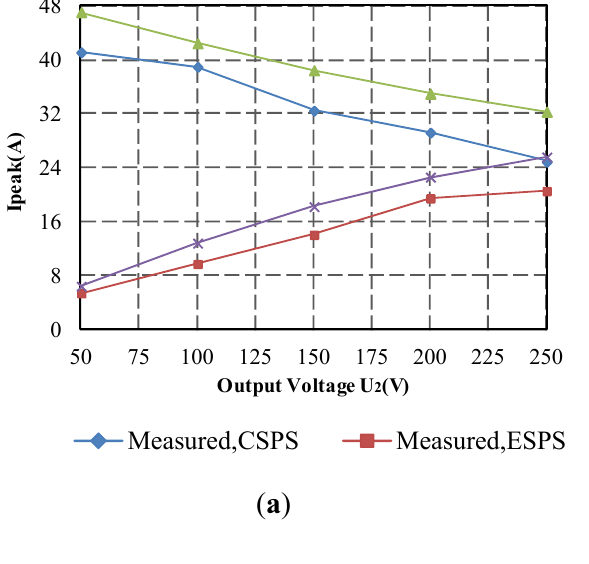
Figure 10. Curves of the current stress and backflow power in both modulation strategies varied with d . ( a ) Peak current; ( b ) Backflow